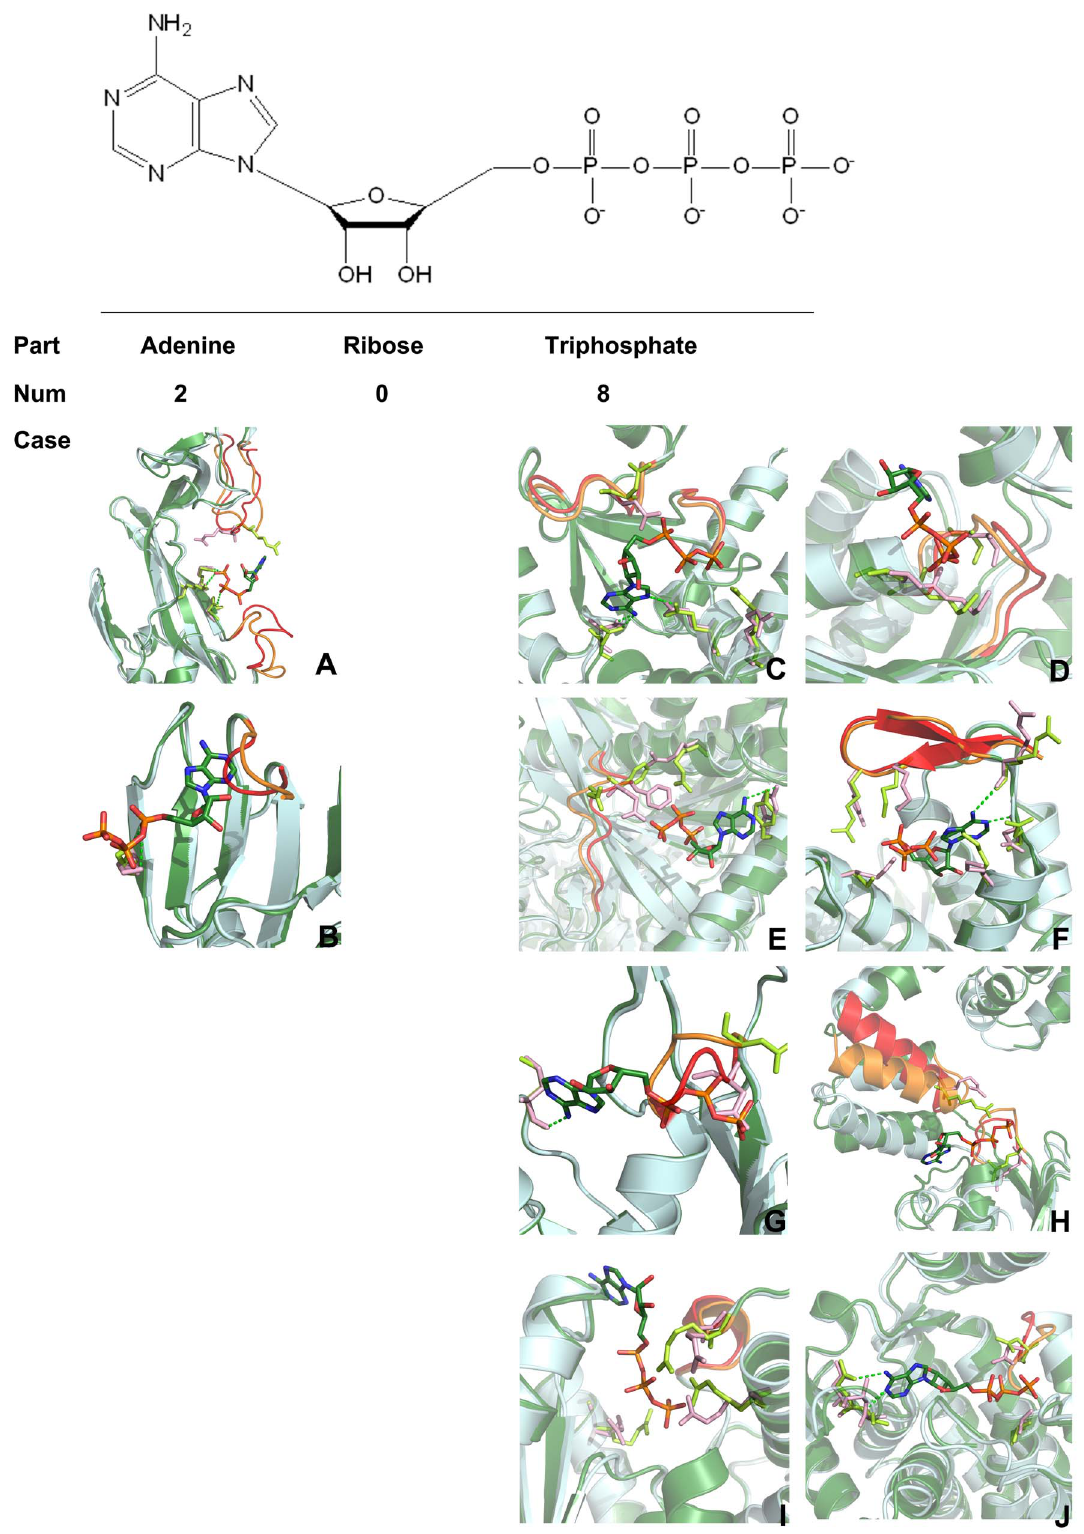
Figure 7. Structural identification of allosteric triggers of an allosteric molecule. The crystal structures of allosteric ATP unbound and bound proteins are shown in pale cyan and dark green, respectively. The relatively large conformational changes in the allosteric ATP unbound and bound proteins are shown in red and orange, respectively, coupled with the residues in light pink and light green, respectively. The adenine in ATP is an allosteric trigger in two cases: (A) P2X 4 ion channel (PDB: 4DW0 vs. 4DW1; the former is allosteric ATP unbound structure and the latter is allosteric ATP bound structure); and (B) Aspartate carbamoyltransferase (PDB: 6AT1 vs. 4AT1). The triphosphate part of ATP is an allosteric trigger in eight